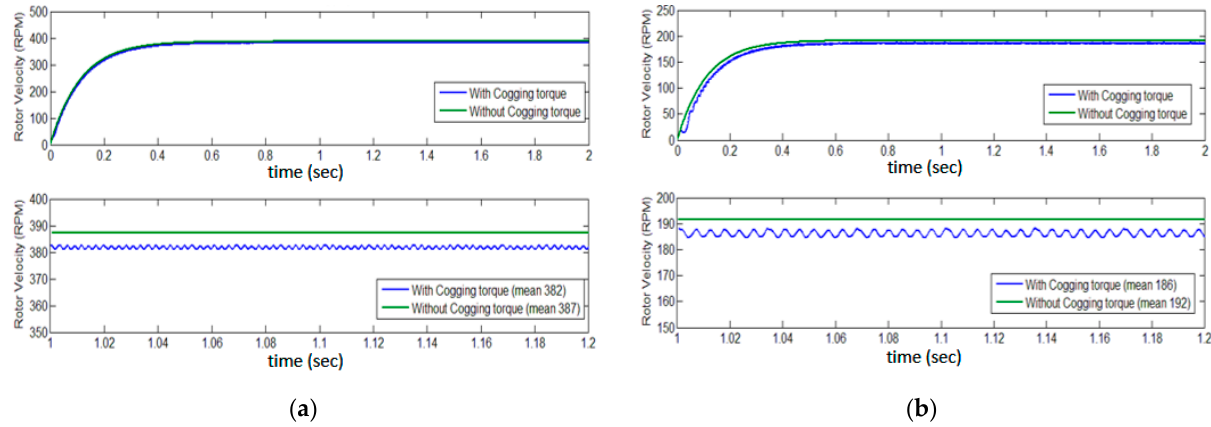
Figure 2. The effect of cogging torque ( a ) on a machine rotating at high speed and ( b ) a machine rotating at low speed.